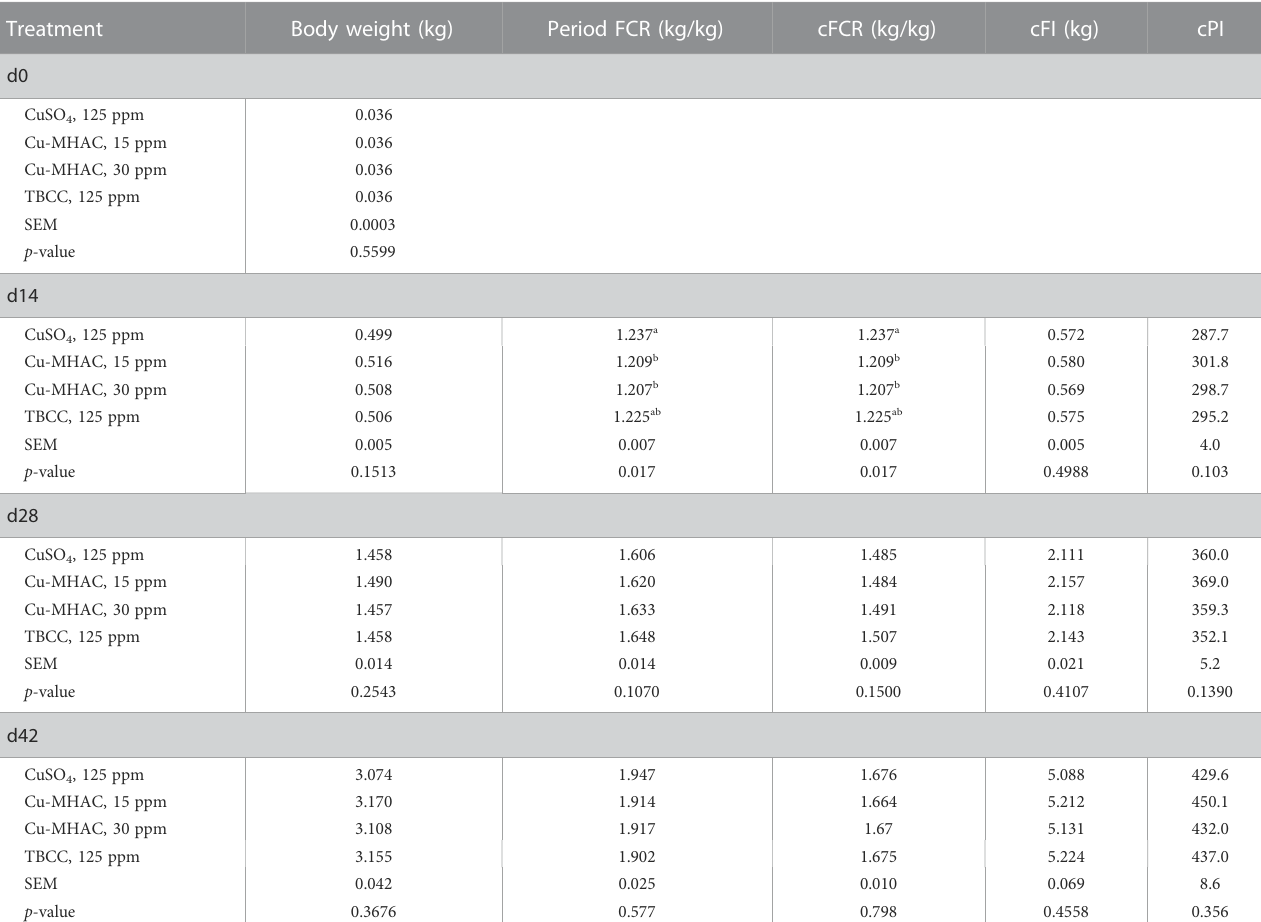
TABLE 12 Growth performance of broilers in experiment